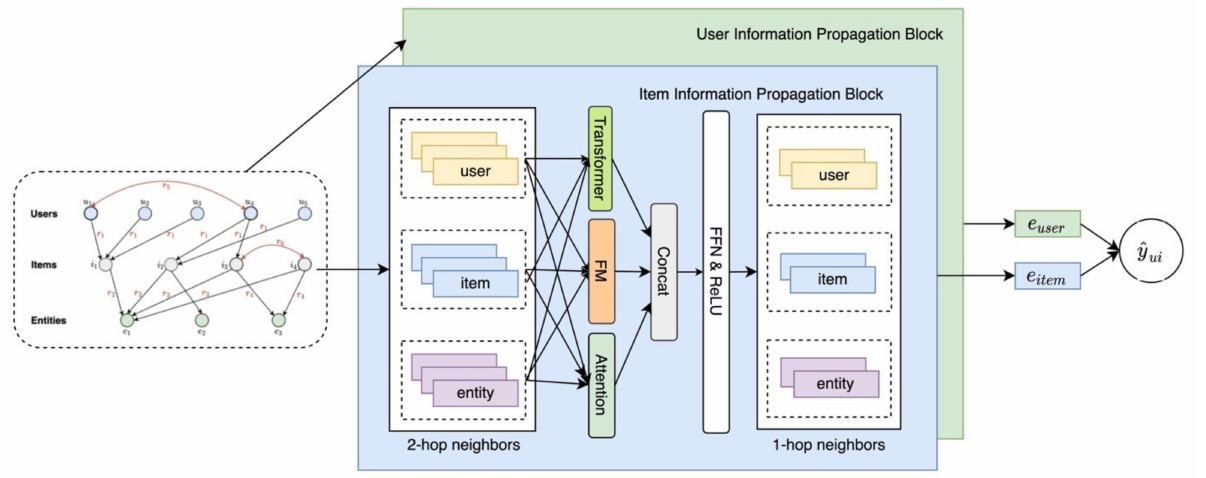
Figure 1. The whole framework of the proposed MAKR